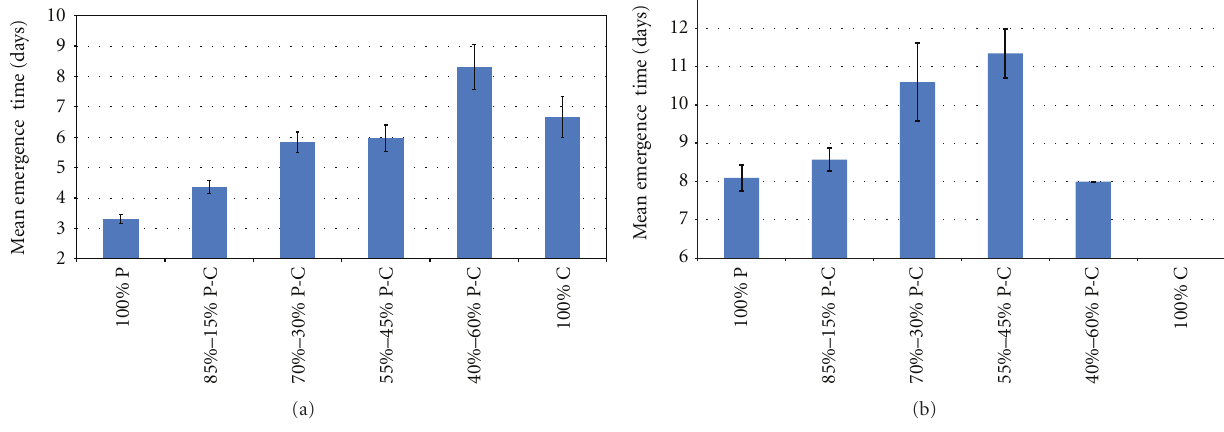
Figure 2: Mean emergence time for marigold and basil in substrate medium (commercial peat :CP; municipal solid waste compost:MSWC) at di ff erent ratios under nursery condition. Values represent mean ( ± SE) of measurements made on 5 replication (4 wells per replication; 5 seeds per well) per